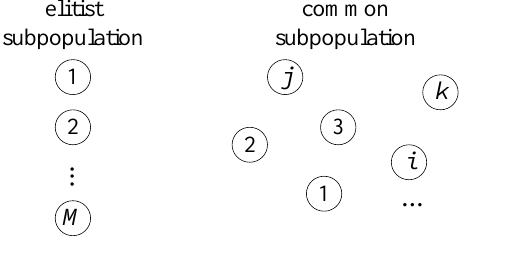
Fig. 1 Elitist Strategy Illustration